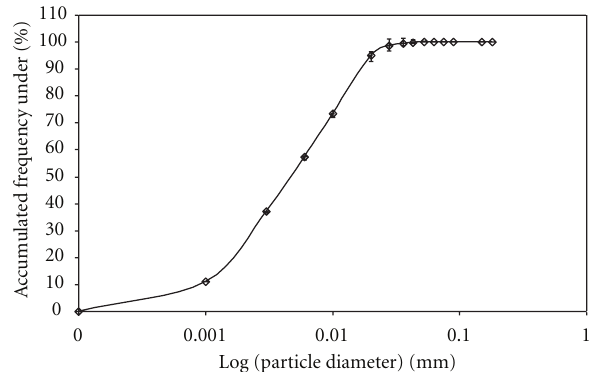
Figure 2: Zeta potential for LZSA, where IEP is at pH = 6 . 46 ± 0 .